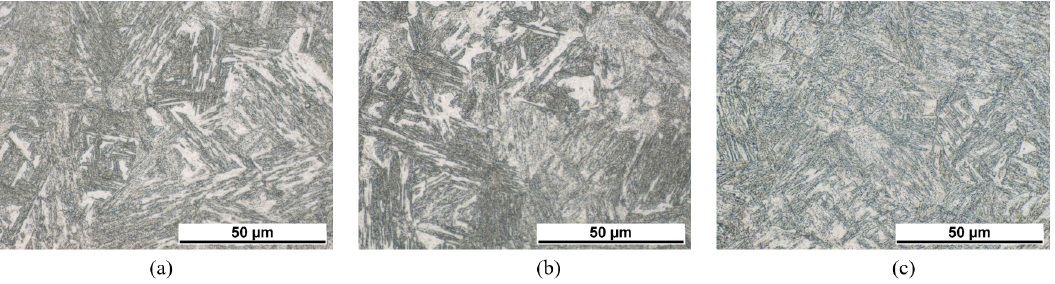
Figure 2. Metallographic micrographs of bainite structure of 22MnB5 after transformation at 450°C under applied stresses— ( a ) 0 MPa, ( b ) 50 MPa, ( c ) 200